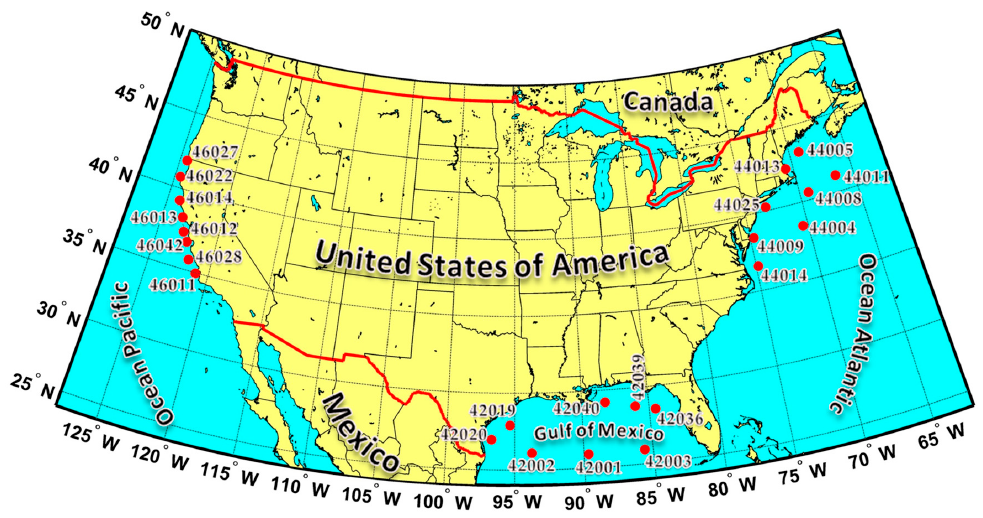
Figure 3. Study areas with relative NOAA-NDBC buoys location and their identification code number.